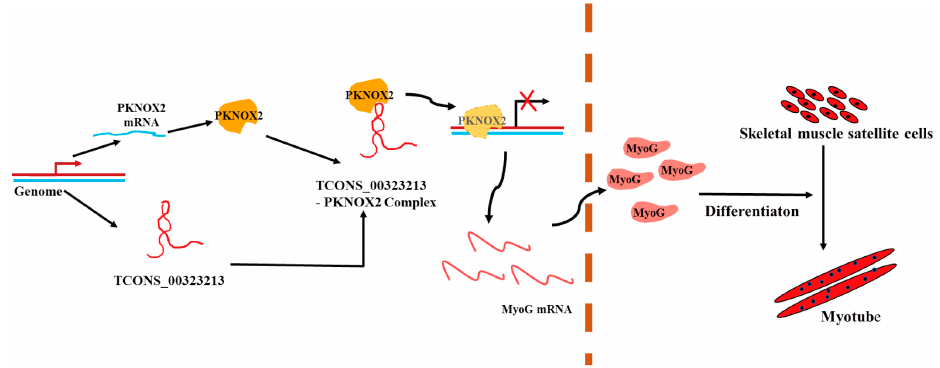
Figure 7. A schematic diagram depicting the functions of TCONS_00323213 during skeletal muscle satellite cell di ff erentiation. In di ff erentiating PSCs, TCONS_00323213 binds to PKNOX2 to relieve the inhibitory e ff ect of PKNOX2 on MyoG , thereby increasing MyoG expression and promoting PSC di ff erentiation.